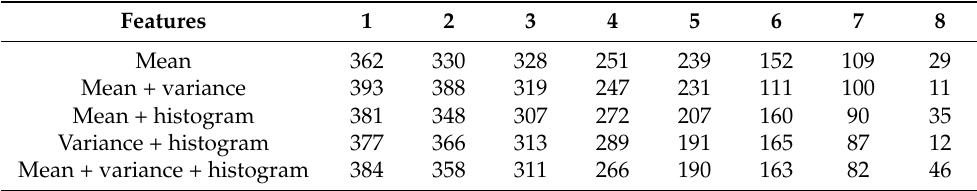
Table 2. K = 8 number of images in each cluster.